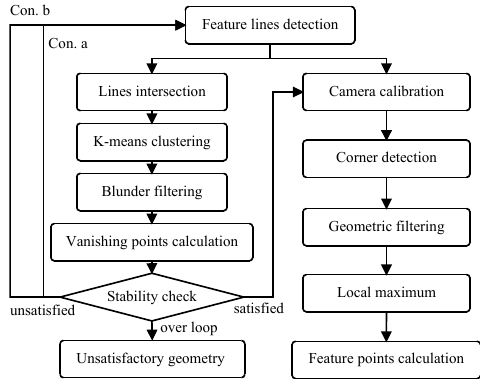
Figure 3. Systematic procedure for vanishing point calculation and feature point extraction. Figure 4 is an example of base point prediction, in which feature points are marked as blue circular dots. According to the vanishing points along Y and Z or X and Z directions, feature points are projected onto the X-Z or Y-Z plane, and the projection path is recorded. The projections for the feature points are marked as red triangles in Figure 4(b). The same procedure is applied to vanishing point along Z direction to project them onto Y or X axis noted as green squares at the bottom of Figure 4(c); then record and link to the vanishing point along y or x direction as the dash lines shown in Figure 4(d). The intersection point to the line linked from feature points to the vanishing point along z direction (vertical line in Figure 4(e)) are the base points (red hollow circular points). In Figure 4(f), green solid lines represent the target heights between the feature points and their corresponding base points to be determined in the next step.